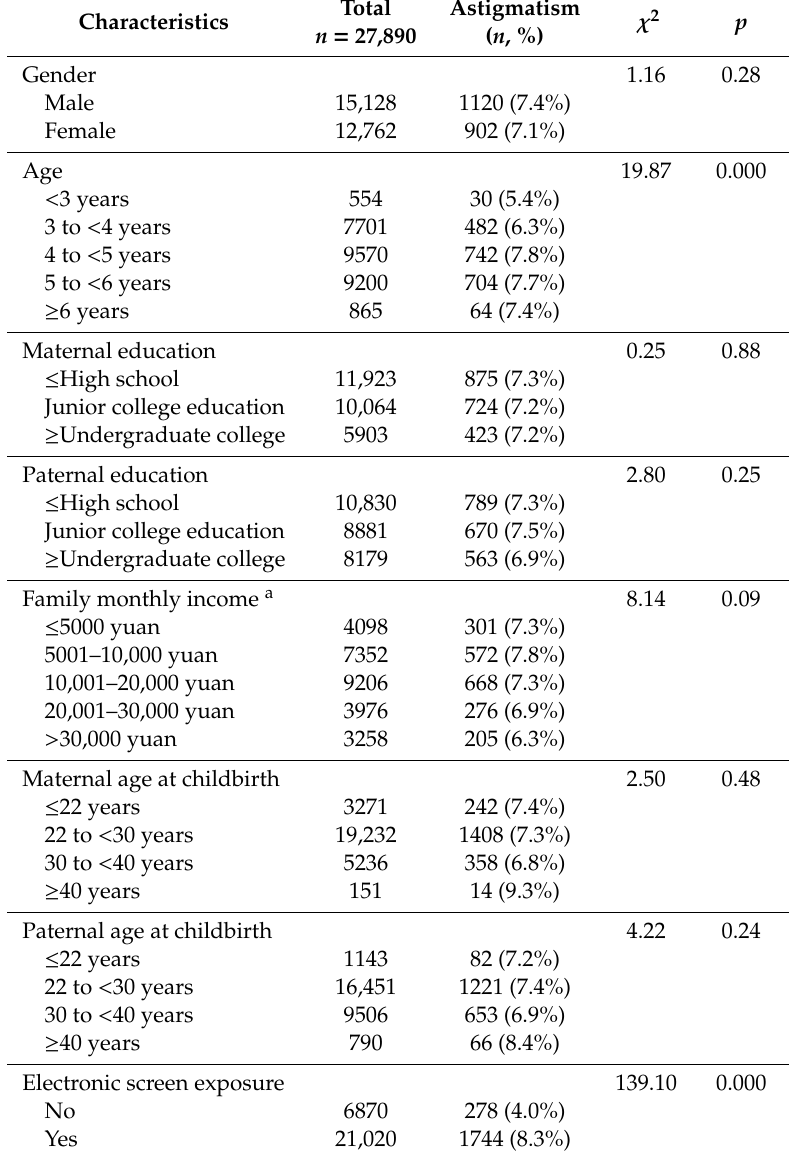
Table 1. Baseline characteristics of the participating children with ( n = 2022) and without ( n = 25,868)